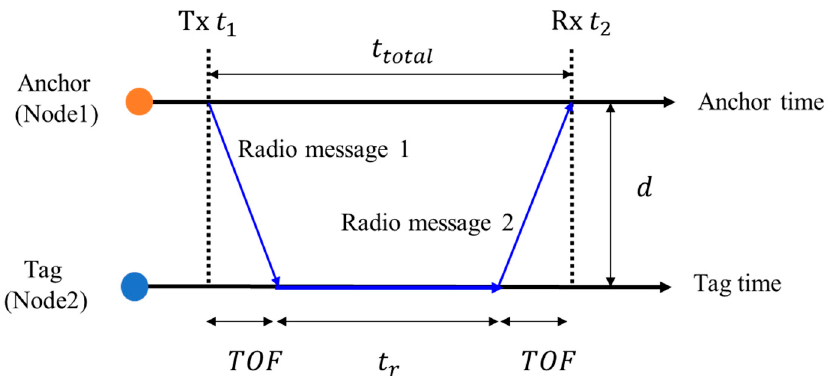
Figure 2. Positioning principle in the two-way ranging (TWR) system.